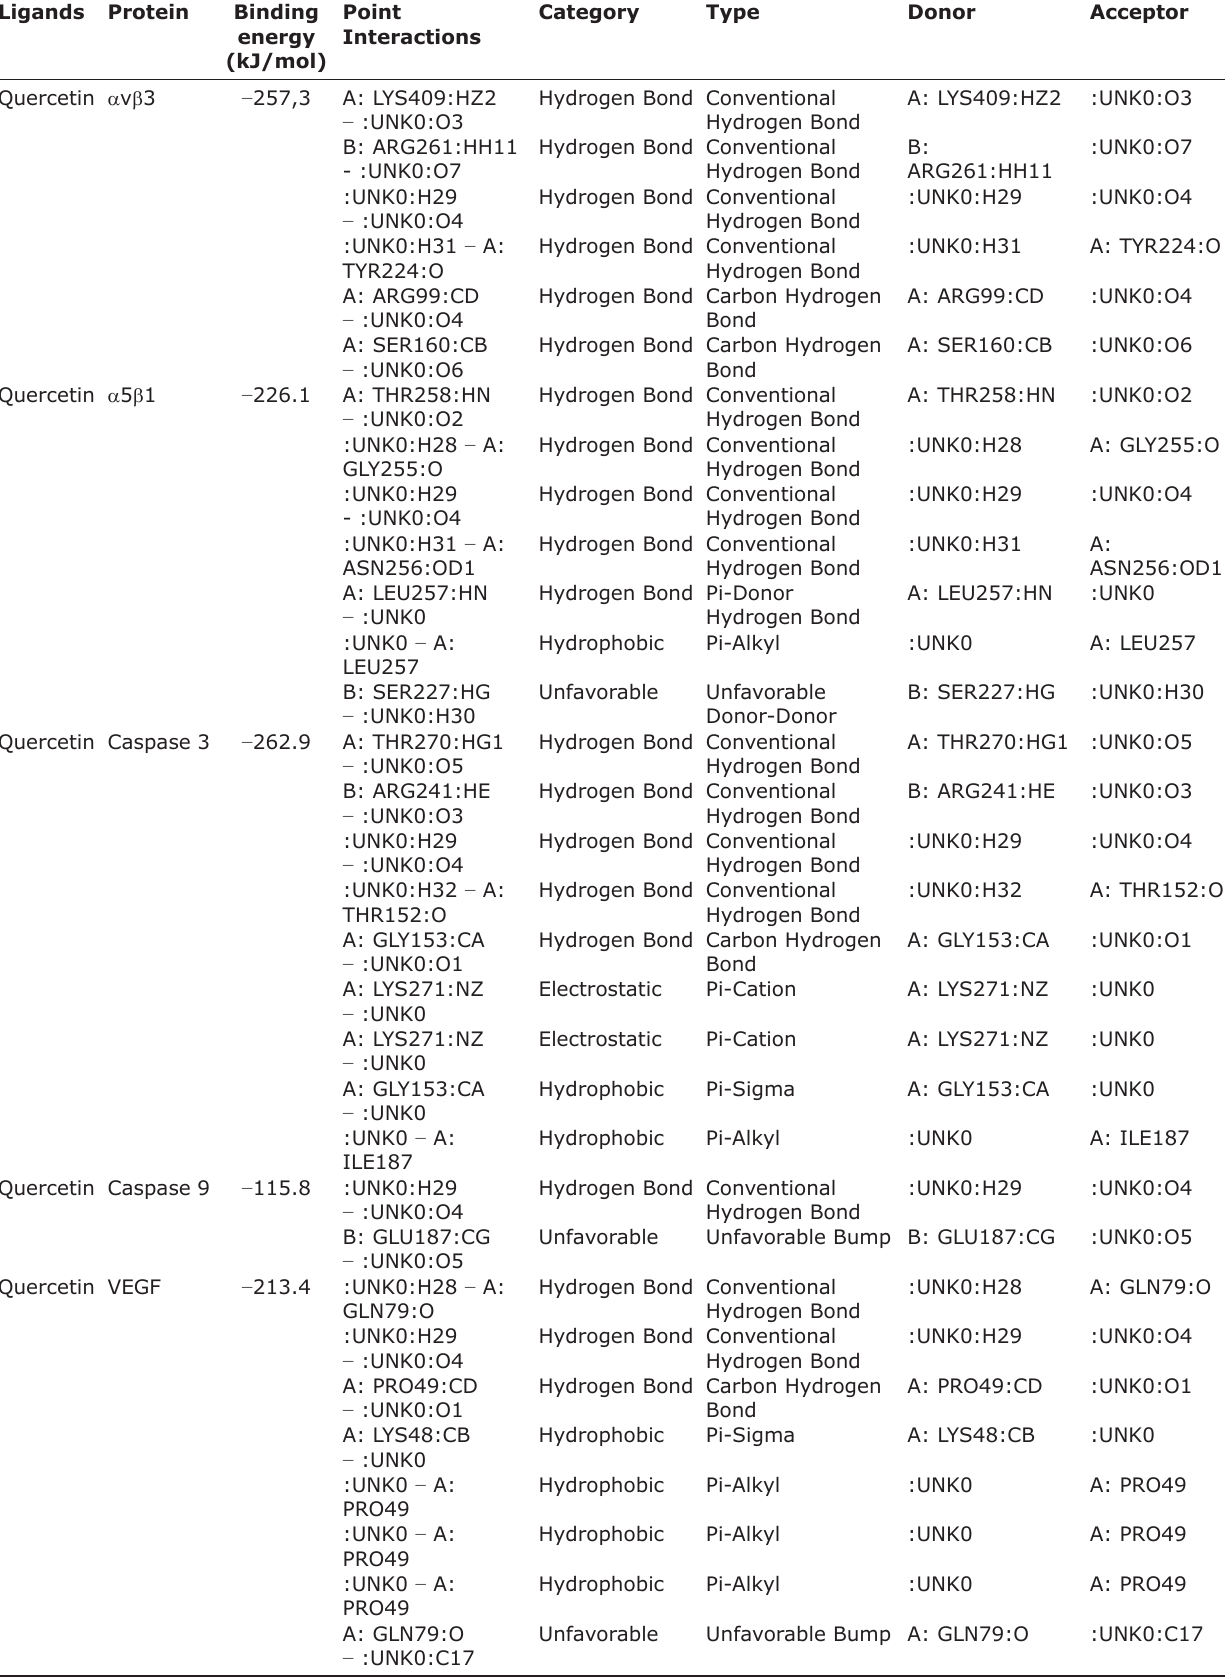
Hydrogen Bond Conventional Hydrogen Bond Hydrogen Bond Carbon